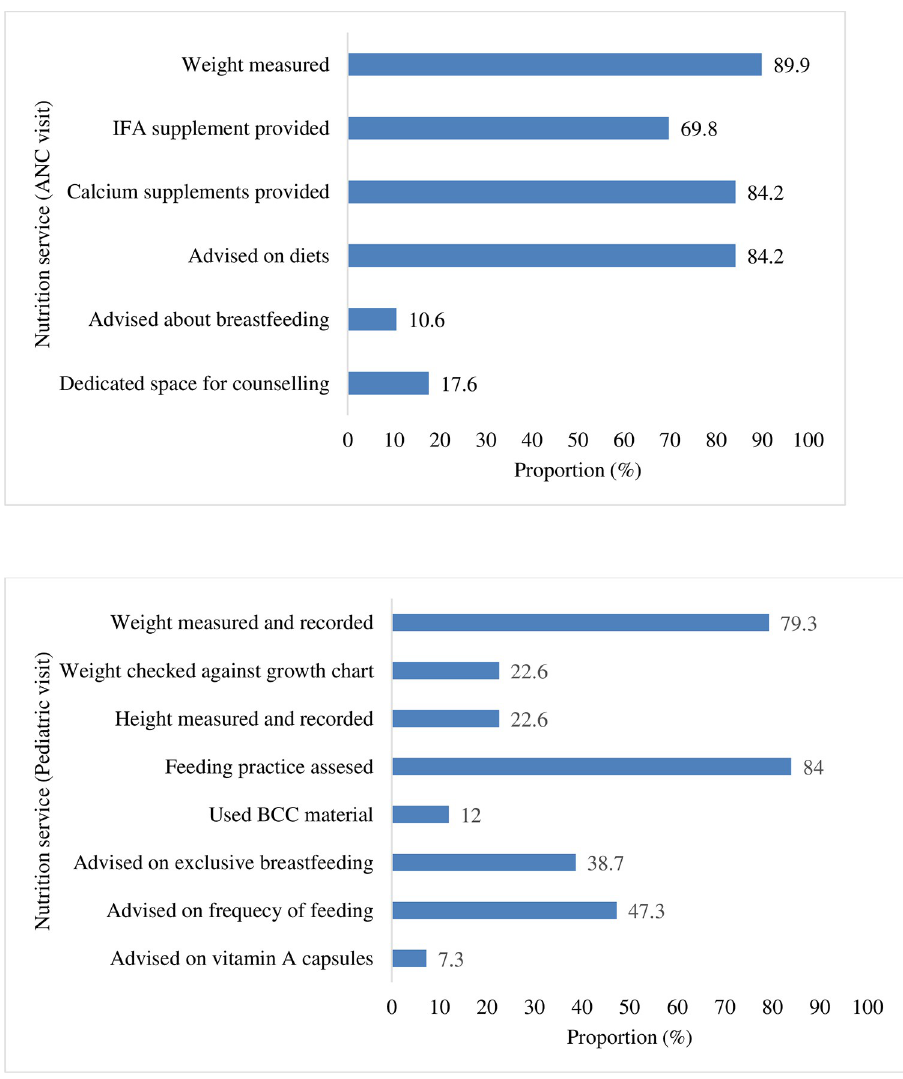
Fig 1. A. Proportion (%) of pregnant women who received nutrition services during ANC (n = 159); B: Proportion (%) of mothers/caregivers of young children who received nutrition services during paediatric visits (n =